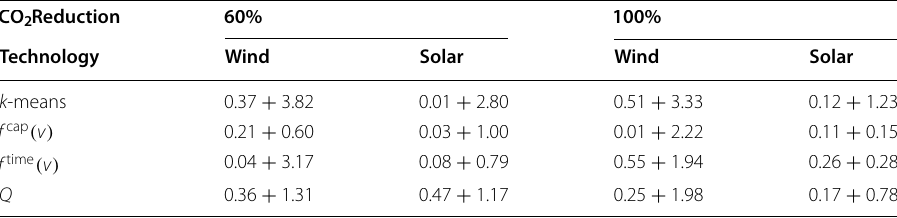
Table 3 Mean squared error presented as a sum of over- and underestimated optimal estimates MSE MSE ( MSE + + − ) according to equation (14) respective clustering method, renewable = technology and carbon reduction target for a spatial resolution of 97 nodes. Graphically presented in Fig.